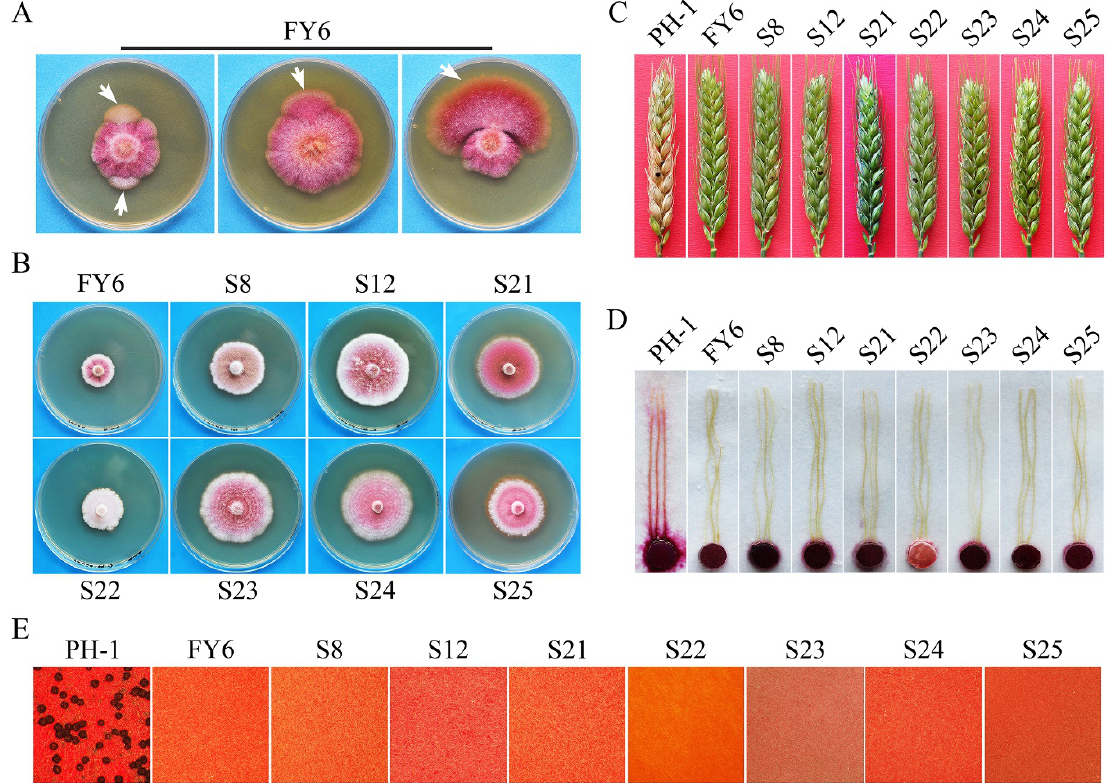
Figure 2. Spontaneous suppressors of the Fgyck1 mutant. ( A ) Sectors with faster growth rate and different pigmentation (marked with arrows) were observed in PDA cultures of the Fgyck1 mutant FY6 older than one week. ( B ) Five-day-old PDA cultures of the Fgyck1 mutant and seven representative suppressors with different growth rate and pigmentation. ( C ) Flowering wheat heads inoculated marked strains were photographed at 14 dpi. Black dots indicate the inoculated spikelets. ( D ) Corn silks inoculated with culture blocks of the same set of strains were photographed at 5 dpi. ( E ) Mating cultures were examined for perithecium formation at 7 dpf. All suppressors were non-pathogenic and failed to produce perithecia.